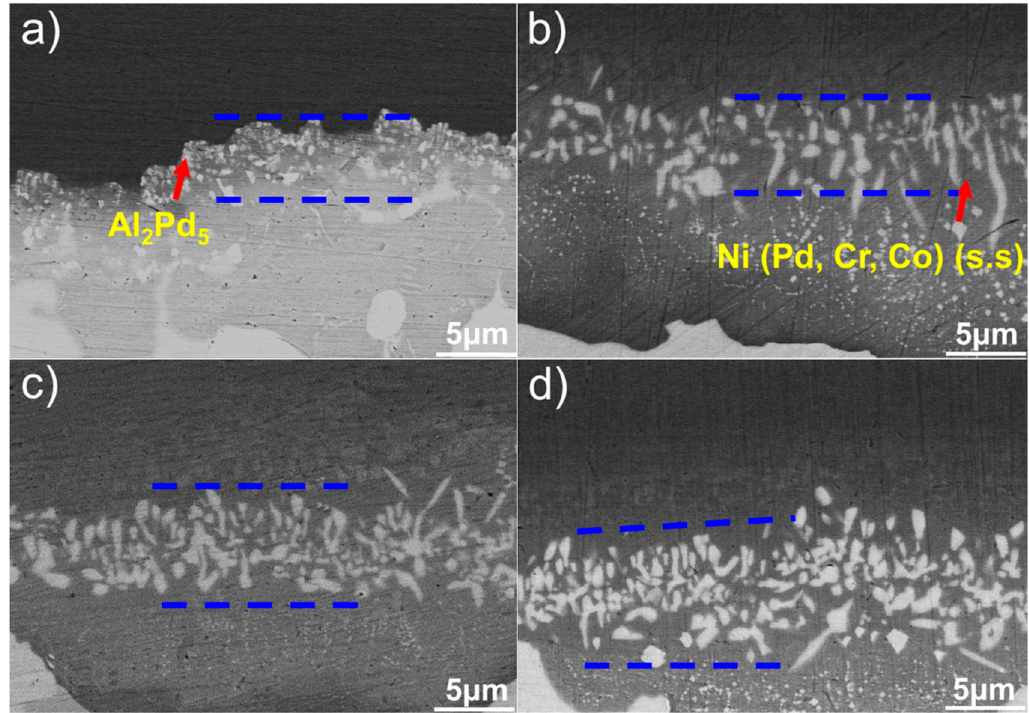
Figure 10. SEM back-scattered electron images of the zone 2 in the DD98M/Pd-Si/DD98M joints brazed at 1060 ° C for different soaking time: ( a ) 10 min, ( b ) 30 min, ( c ) 60 min, and ( d ) 90 min.